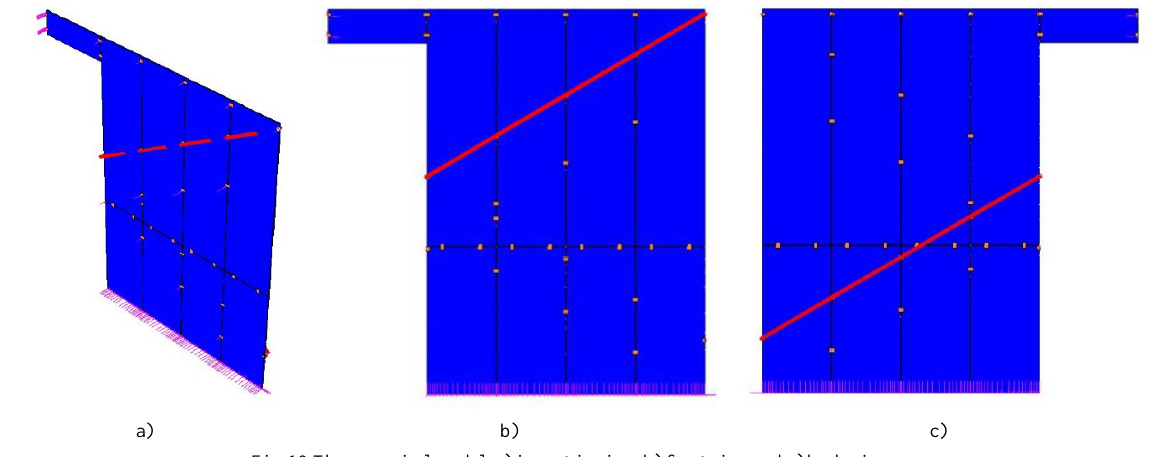
Fig. 13 The numerical model: a) isometric view, b) front view and c) back